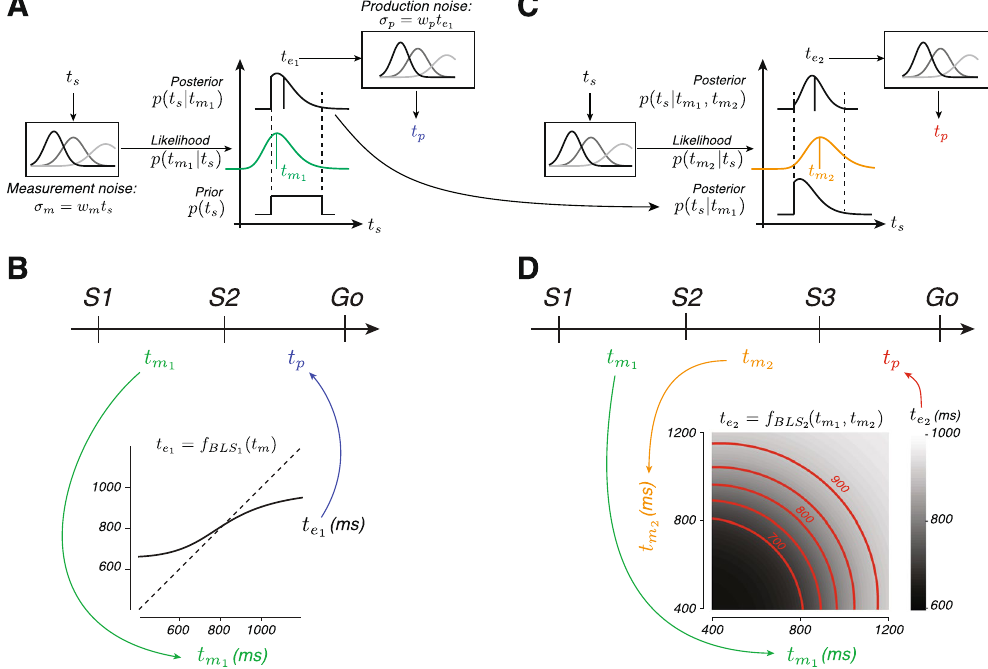
Figure 3. BLS model of interval integration. ( A ) BLS model for 1-2-Go trials. The left panel illustrates the measurement process. The measured interval, t , is perturbed by zero-mean Gaussian noise whose standard m 1 deviation is proportional to the sample interval, t s , with constant of proportionality w m ( σ m = w m t s ). The middle panel illustrates the estimation process. The model multiplies the likelihood function associated with t m 1 (middle panel, green) with the prior (bottom), and uses the mean of the posterior (top) to derive an interval estimate ( t , black vertical line on the posterior). The right panel illustrates the production process. The e 1 produced interval, t p , is perturbed by zero-mean Gaussian noise with standard deviation proportional to t , e 1 σ = ). ( B ) The effective mapping function ( f with constant of proportionality w p ( w t , black curve) from p p e 1 BLS 1 the first measurement, t , to the optimal estimate, t . The dashed line indicates unity. ( C ) BLS model for 1-2-3- m 1 e 1 | , as the prior and combines it with Go trials. The model uses the posterior after the first measurement, p t t ( ) s m 1 , orange) to compute an updated posterior, | p t t t ( , ) . The the likelihood of the second measurement ( t s m m 1 2 m 2 mean of the updated posterior is taken as the interval estimate ( t ). ( D ) The effective mapping function ( f , e 2 BLS 2 grayscale) from each combination of measurements, t and t , to the optimal the estimate, t . Red lines m 1 m 2 e 2 indicate combinations of measurements that lead to identical estimates (shown for = t 700, 750, 800, 850, and e 2 900